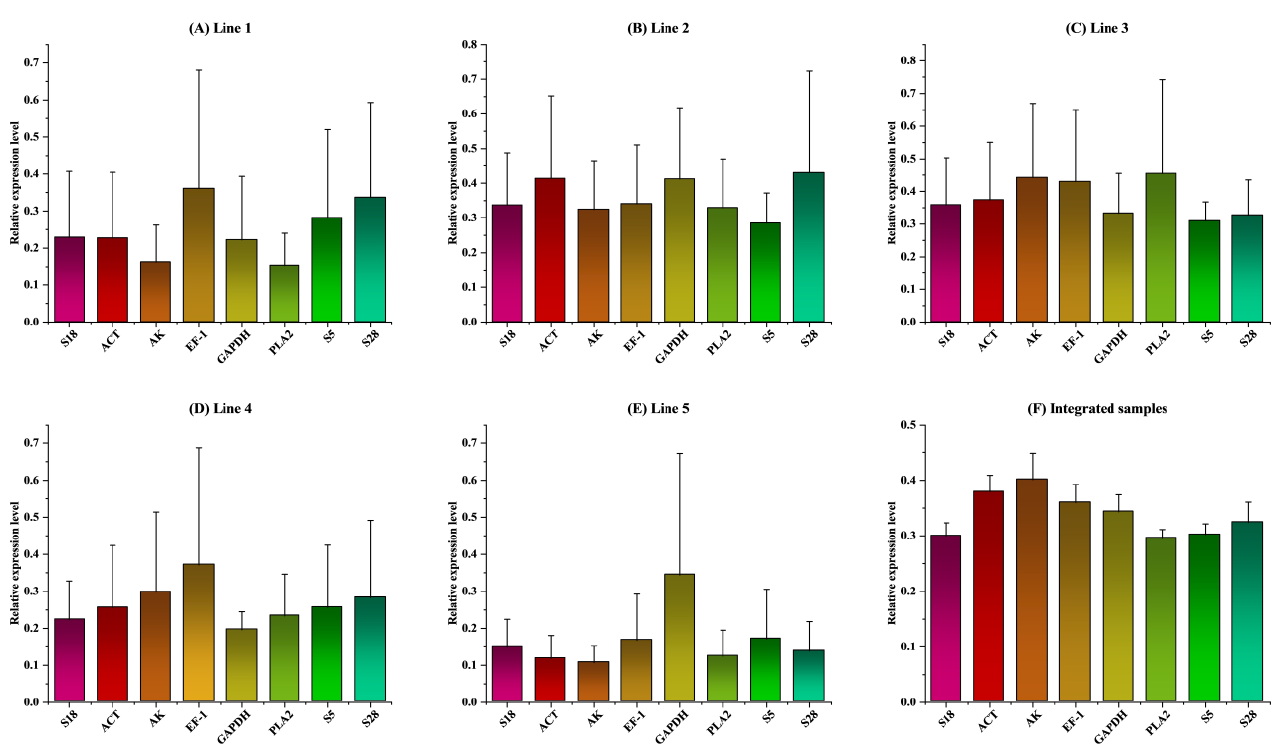
Figure 6. Variations in the levels of expression of the genes that could function as references in different lines. B. terrestris line samples (( A ) line 1, ( B ) line 2, ( C ) line 3, ( D ) line 4, ( E ) line 5)), ( F ), Integrated samples of B. terrestris . The expression levels of these genes in the bumble bee samples were standardized with respect to the Ct values of Vg, which is an internal target gene. The graphs present the relative mRNA expression values that were determined by the application of the 2 −ΔΔCt technique. Comparing the groups at a significance level of 0.05 required the use of a one-way analysis of variance (ANOVA), followed by a post hoc analysis that included multiple comparisons. The values that are displayed represent the mean ± SE.